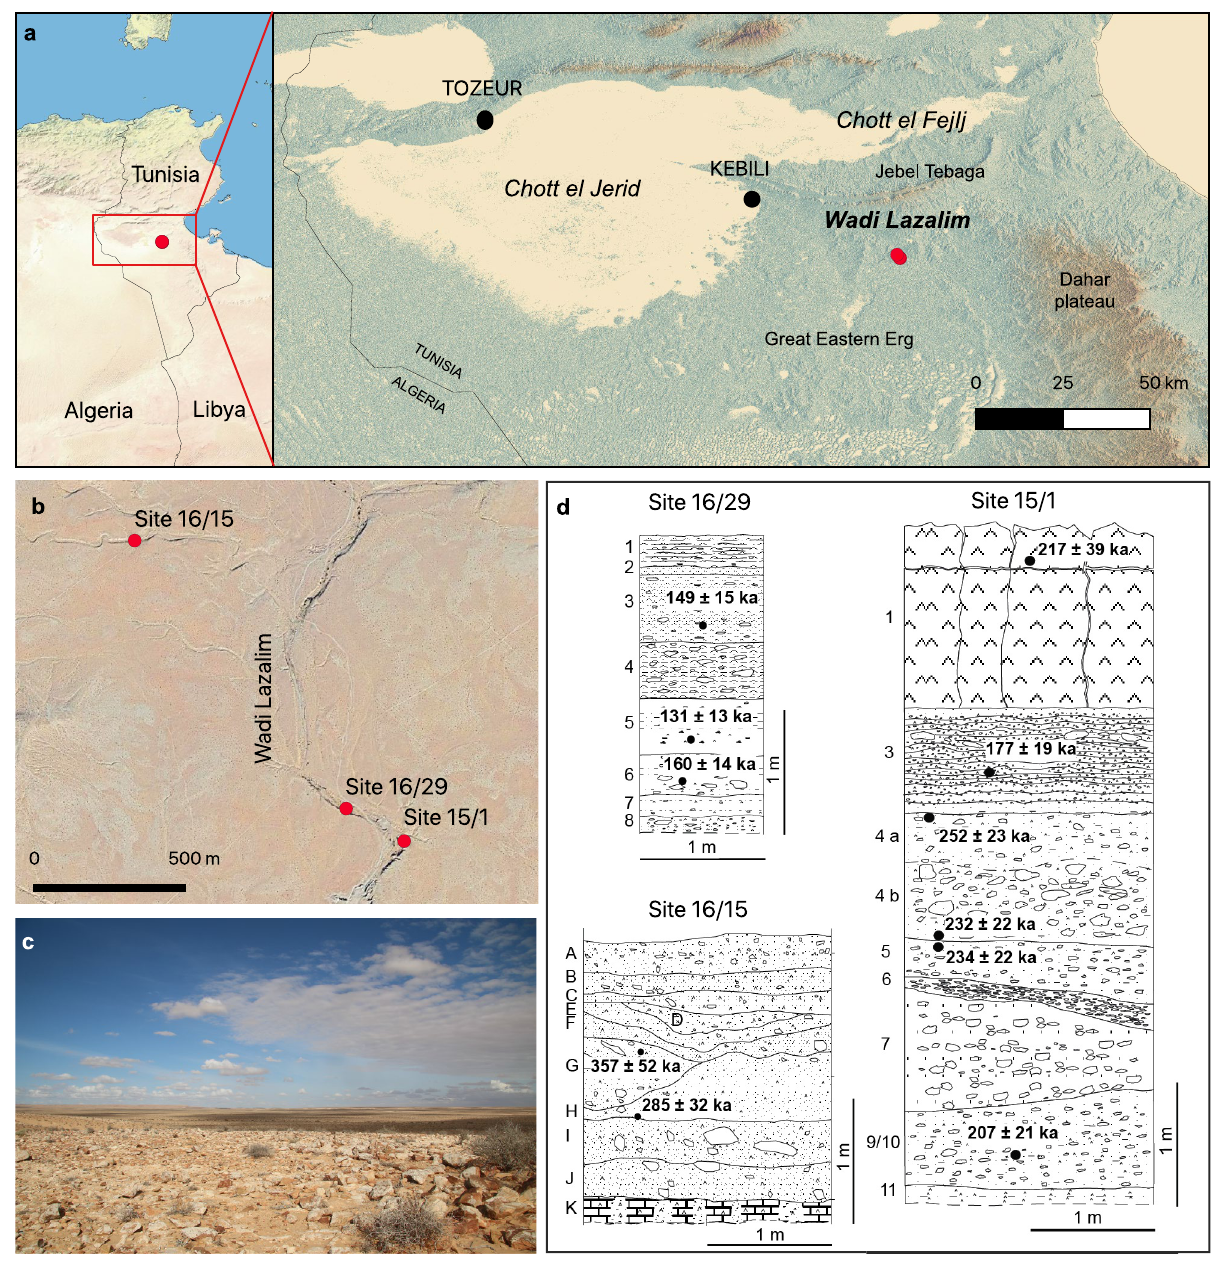
left, made with Natural Earth; right, made with SRTM 1 ArcSec); b : satellite view of the area encompassing the excavated sites (Google Earth); c: view of Wadi Lazalim from the heights north of site 16/15 looking eastwards; d: drawing of the excavated stratigraphic sections at Site 16/29 (South profile), Site 16/15 (South profile) and Site 15/1 (East profile) with indication of results from the IRSL dating (description of the sedimentary units in Supplementary Information); numbers and letters to the left of each section indicate layer